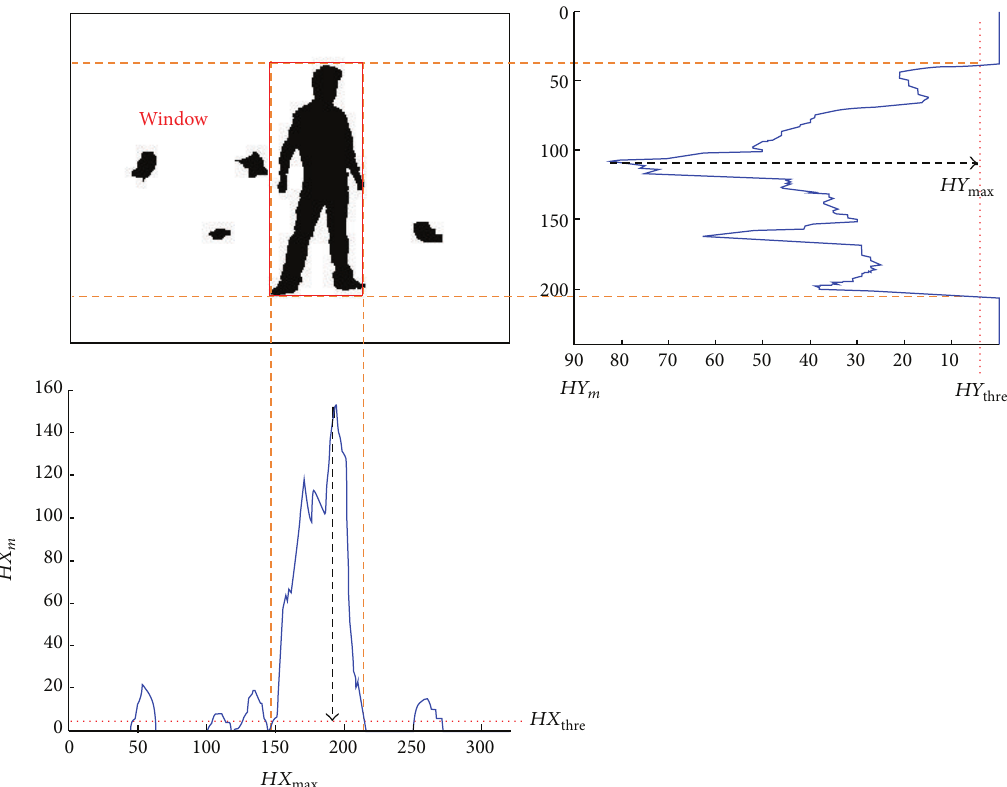
Figure 2: Segmented image, its vertical and horizontal histograms, and position of the found window